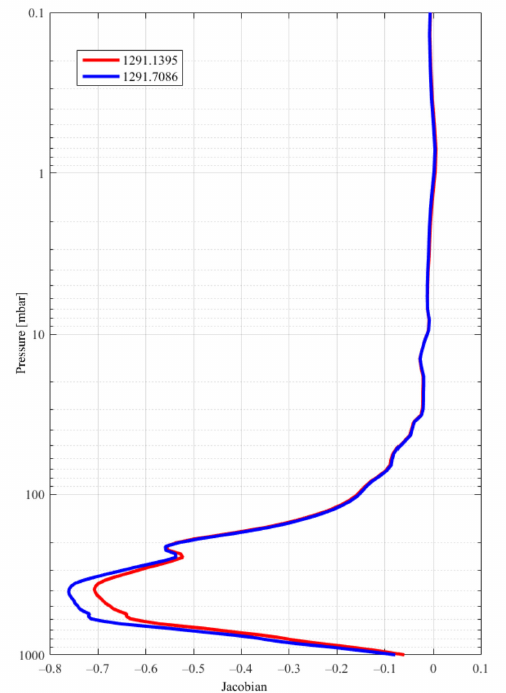
Figure 6. Weighting functions of the channels selected near the υ 1 absorption band of N 2 O. From the weighting functions of the channels selected near the υ 3 absorption band of N 2 O, we noticed that most of the peaks overlap on each other. Only 13 channels with the largest peaks in various atmospheric pressure layers are selected for retrieval, as shown in Figure